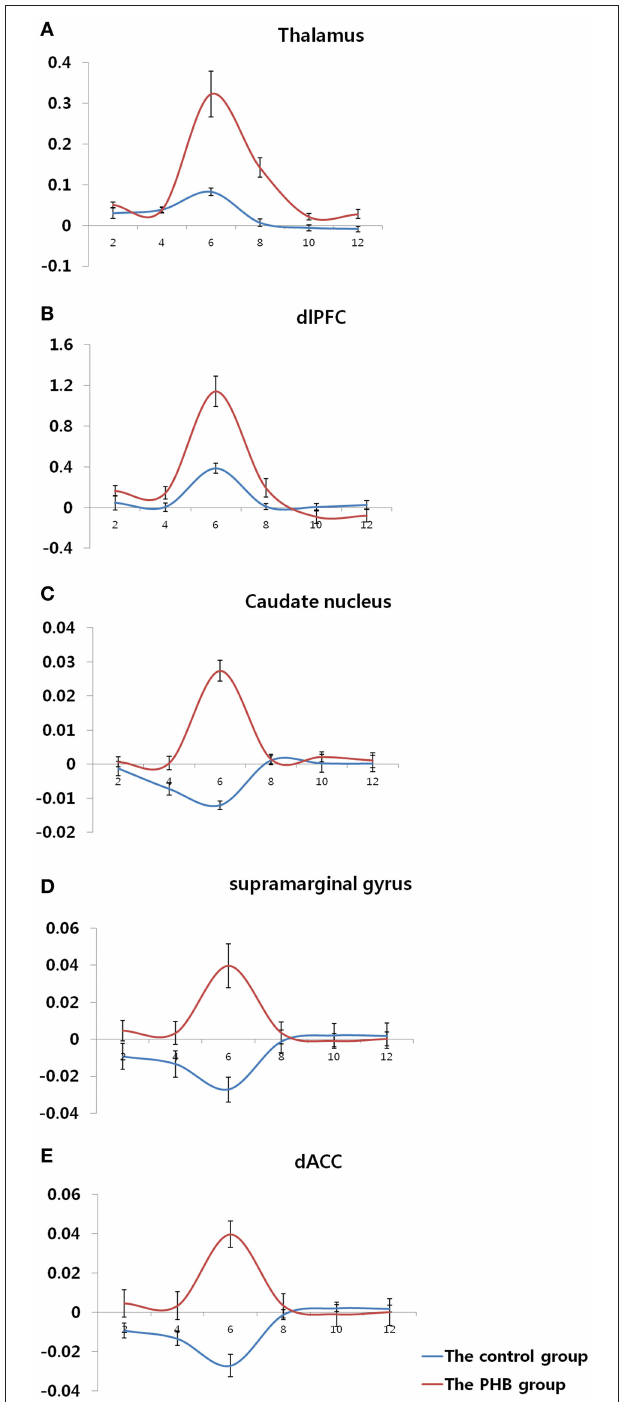
FIGURE 3 | Time course of the hemodynamic responses in each region of interest. (A) Bilateral thalamus (MNI coordinate; x = 6 , y = − 36 , z = 4 ) (B) Right dorsolateral prefrontal cortex (MNI coordinate; x = 56 , y = 10 , z = 22 ) (C) Left caudate nucleus (MNI coordinate; x = − 38 , y = − 32 , z = 2 ) (D) Right supramarginal gyrus (MNI coordinate; x = 50 , y = − 42 , z = 32 ) (E) Right dorsal anterior cingulate gyrus (MNI coordinate; x = 24 , y = − 16 , z = 34 ). The y-axis and x-axis display the percent signal change and time (s), respectively, and the error bars represent the Standard Error of the